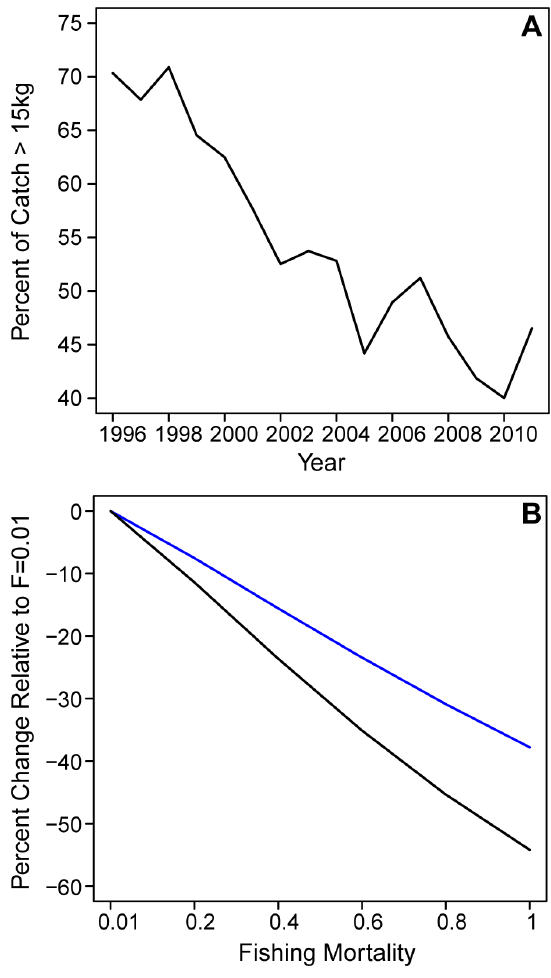
Figure 5. Percent change in catch and biomass. Panels indicate ( A ) the percent of the observed catch . 15 kg, by year and ( B ) the percent change in the size-based model large fish catch and biomass relative to F=0.01 for F ranging from 0.2 to 1.0 for the proportion of catch $ 15 kg (blue) and the proportion of exploitable biomass . 0.1 kg that is $ 15 kg (black).